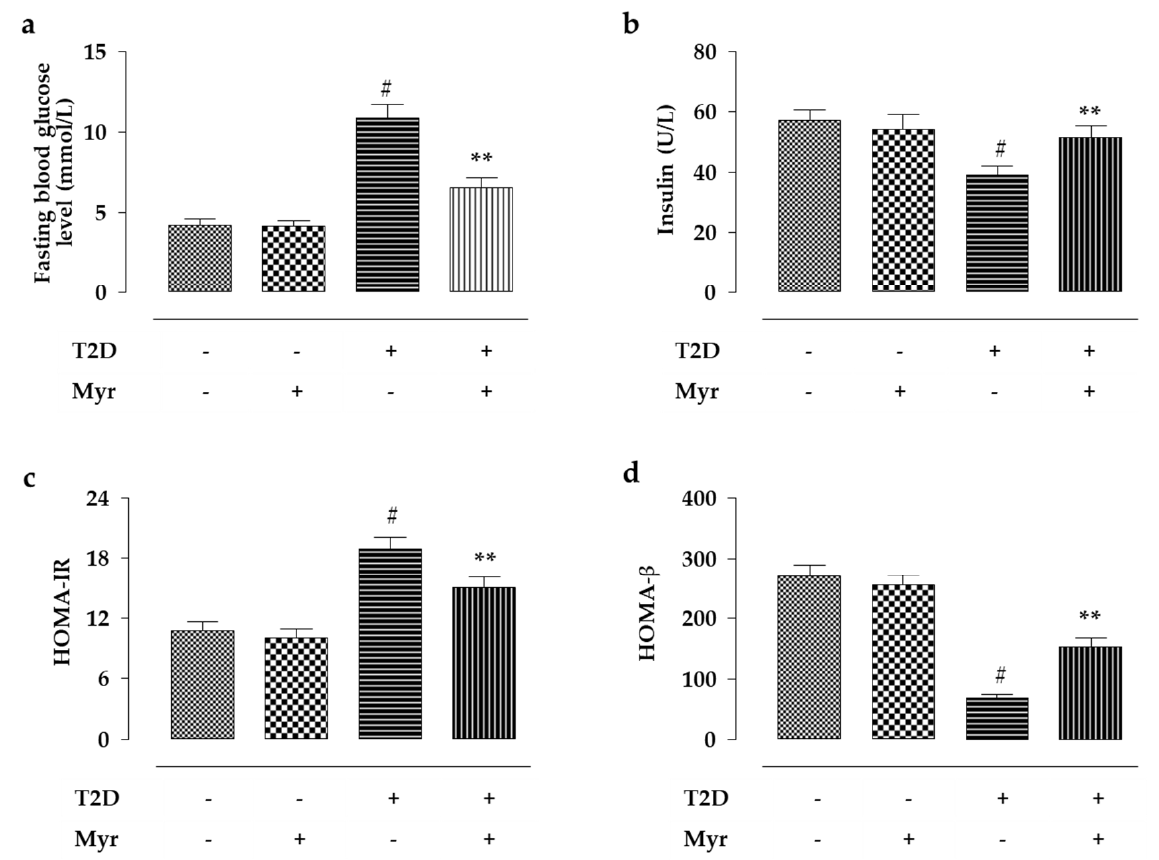
Figure 7. Effect of Myr on fasting blood glucose level (mmol/L) ( a ), serum insulin (U/L) ( b ), HOMA-IR, ( c ) score and HOMA- β score ( d ) on day 29 of post-treatment in T2D rats. Myr was effective in reducing blood glucose level and HOMA-IR score in T2D rats, while it improved serum insulin and HOMA- β score. Data are expressed as mean ± SD ( n = 6). # Values significantly ( p < 0.01) differed from the normal control (T2D − ) group. ** Values significantly ( p < 0.01) differed from the diabetic control (T2D+) group. HOMA-IR = (Fasting serum insulin in U/L × Fasting blood glucose inmmol/L)/22.5; HOMA- β = (Fasting serum insulin in U/L × 20/Fasting blood glucose in mmol/L)—3.5.